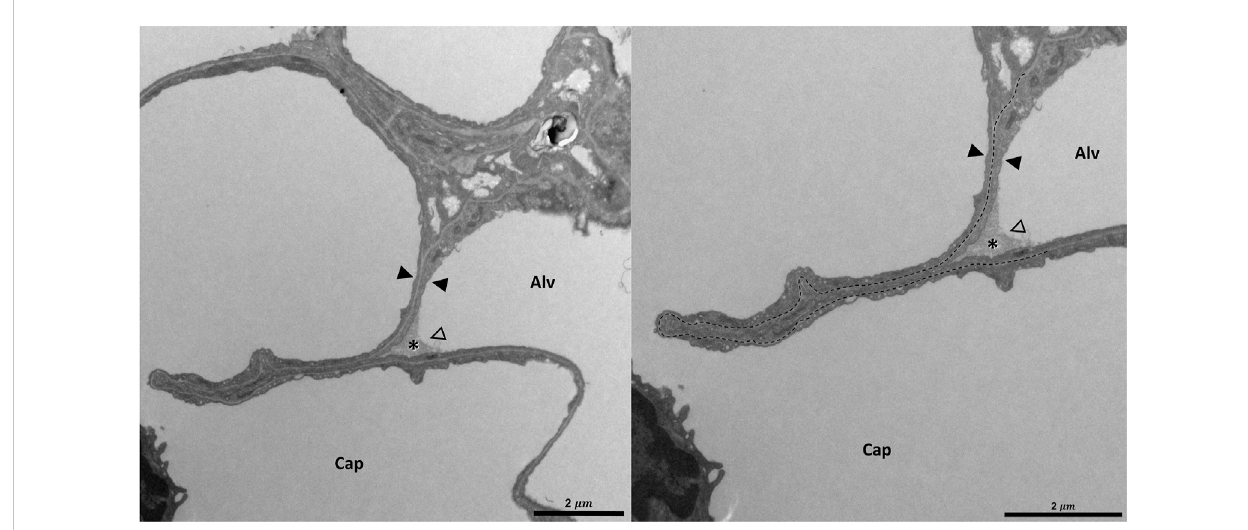
FIGURE 8 Pleatingoftheblood-gasbarrier:Ahealthyratlungwas fi xed invivo byvascularperfusion via thevenacavacaudalisatanairwayopeningpressureof 5 cmH 2 O on expiration after two recruitment maneuvers (3 s pause at 30 cmH 2 O) (Knudsen et al., 2018). The capillary network is open and nearly free of blood cells. The empty arrowhead points to the entrance of a pleat that is fi lled with a protein containing fl uid (asterisk). Pleats are generally fi lled with a smallquantity ofproteinaceous fl uidbut occasionally locations ofdirect epithelial-epithelialcontactare observed. The pleatislimited totheblood- gas barrier, which invaginates into a capillary (Cap). Two fi lled arrowheads locate the blood-gas barrier. The image on the right shows the run of the basement membrane (black dashed line), shared by the endothelial cell and the alveolar epithelial type 1 cell, within the pleat.